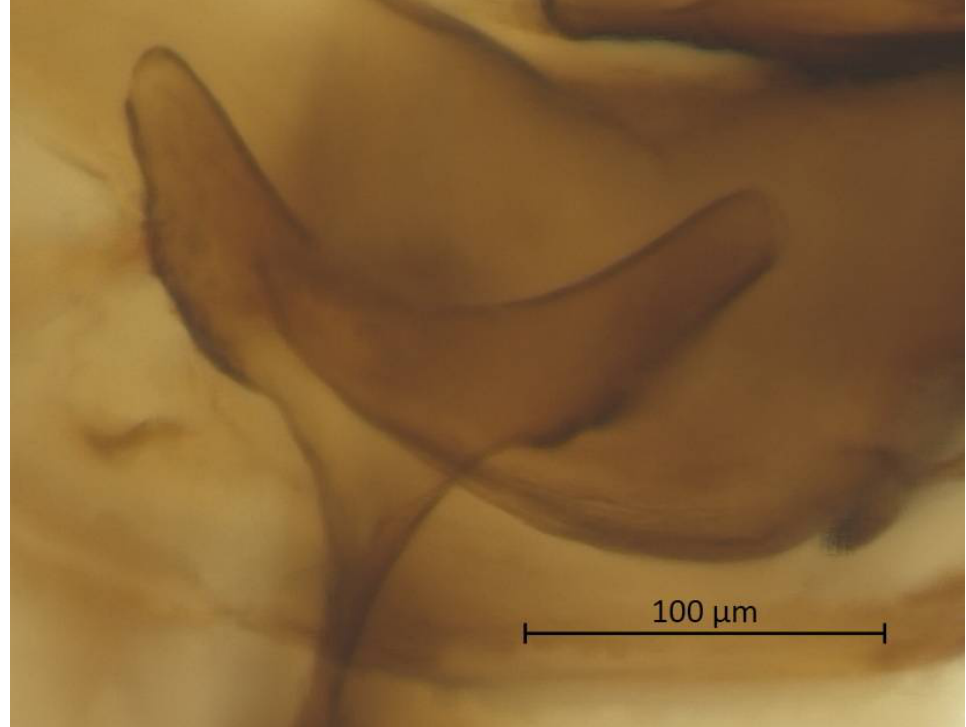
Figure 5. Antenna (ANT III-VI) and sensoria of Qiao jinshaensis sp. nov. (QMOR66201).